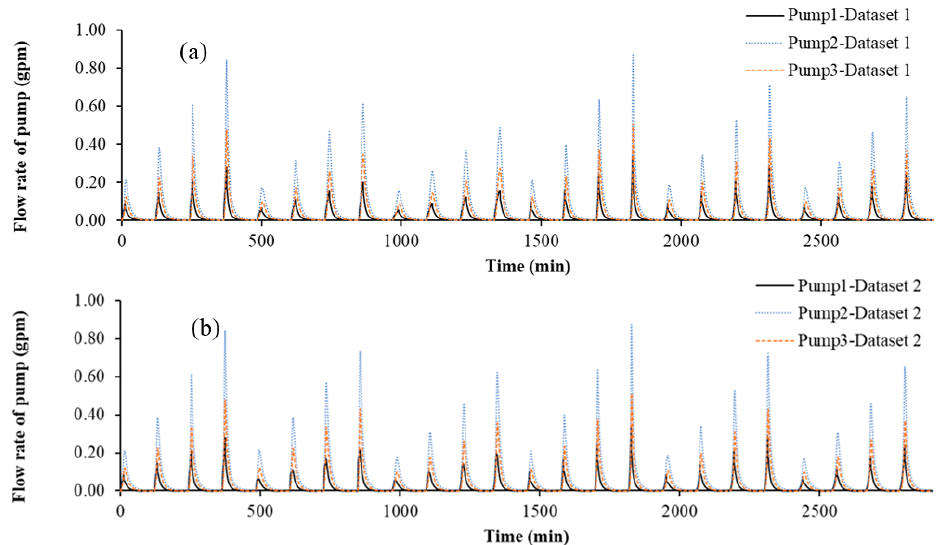
Figure 15. Time series of flow rate for pumps 1, 2, and 3 corresponding to the generated rainfall data